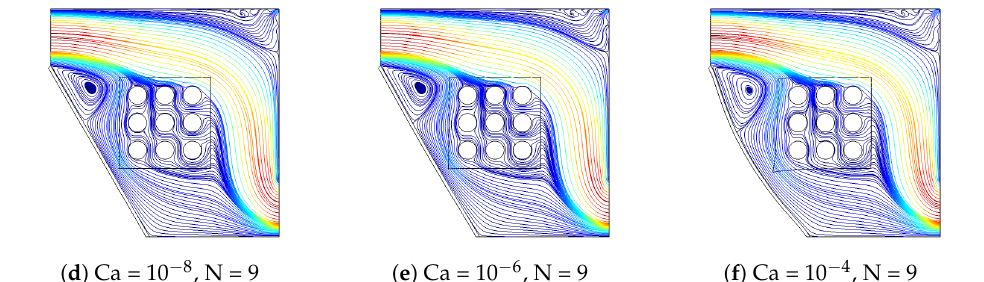
Figure 10. Impacts of Ca number of the streamline variations for the VC system without plate ( a – c ) and with PPP ( d – f ) (Re = 800, Ha = 15, Da = 10 − 2 ).